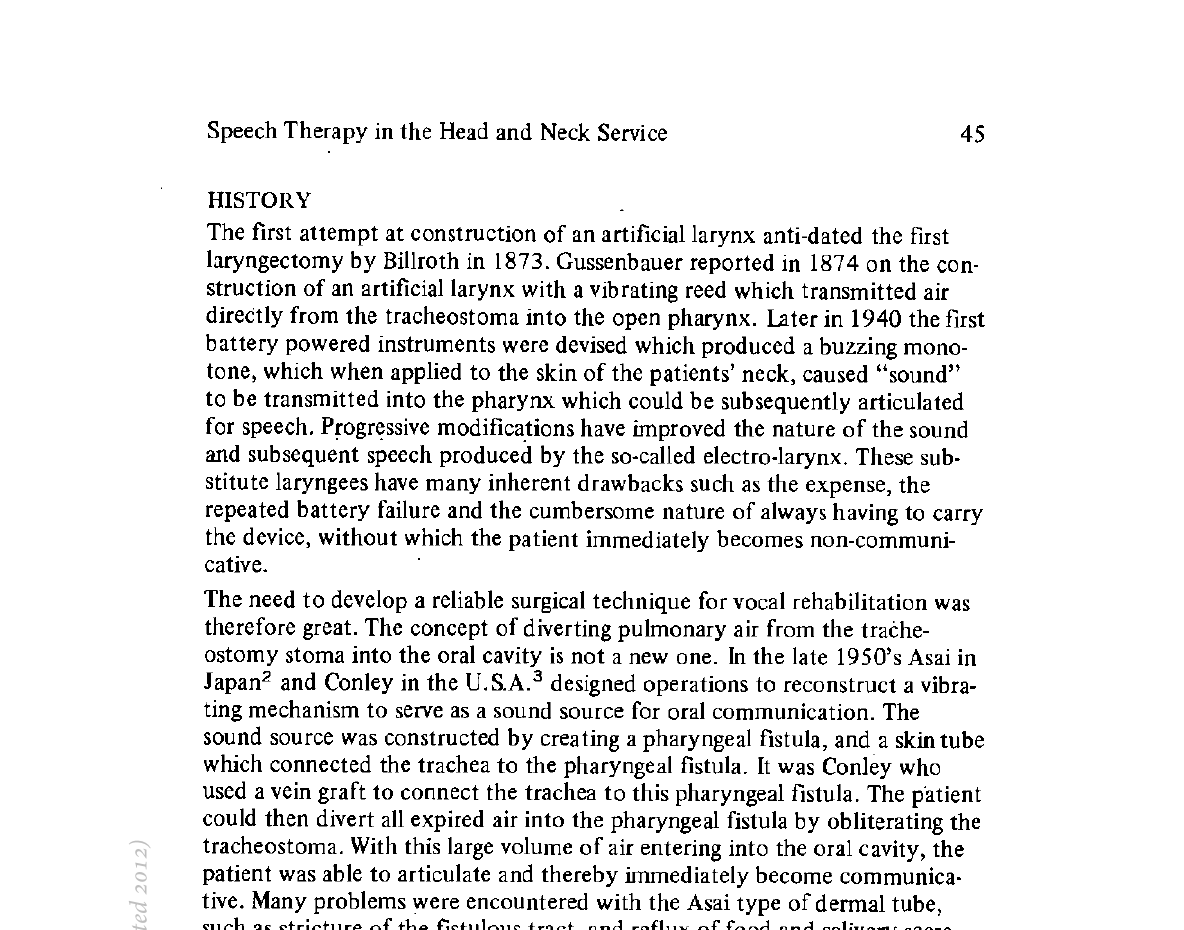
SHOWING TRACHEOSTOMY STOMA AND DELIBERATE PHARYNGEAL FISTULA